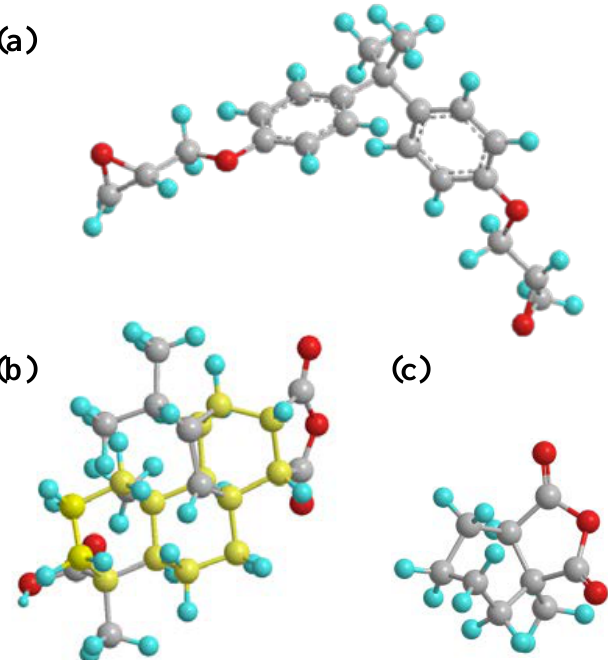
Figure 7. Molecular structures and cross-linking of DGEBA, MPA, and MMHPA. The monomer molecules of DGEBA, MPA, and MHHPA were constructed using Materials Studio (MS) molecular simulation software, and the geometric configuration was optimized for each of the three molecules by the Dmol3 module, as shown in Figure 8. Finally, the Amorphous Cell module was used to construct three-dimensional periodic amorphous cell models for each of the five blending ratios according to the content ratio of each component shown in Table 2. The density of each of these cell models is 0.6 g/cm 3 .